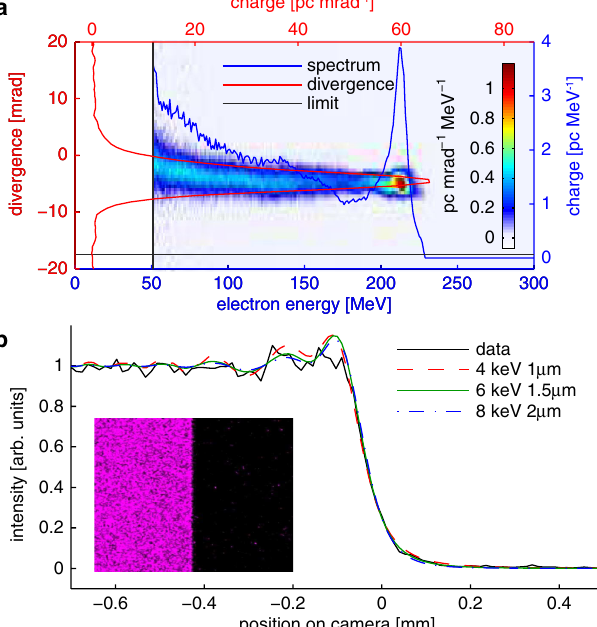
shown in Fig. 2(b) and can be modeled with Fresnel diffraction theory, yielding x-ray spectrum and source size [20]. Using a least-squares method, the rms x-ray source radius (transverse electron bunch radius) is calcu- lated with 95% confidence interval, as shown in Fig. 3, right axis. Much like the divergence, the x-ray source size also shows little correlation with density.